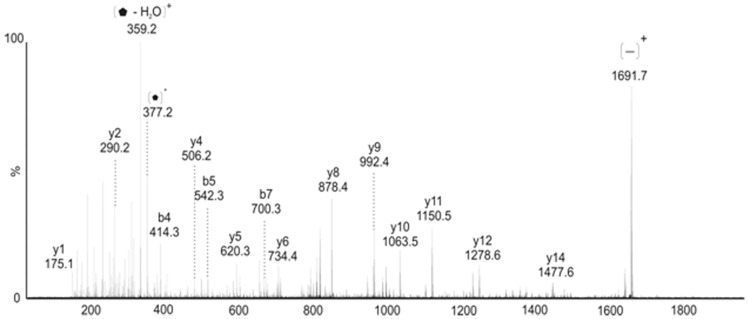
nLC-MS/MS AH-2767 gne mutant polar flagellin glycopeptide spectrum.nLC-MS/MS spectrum of the doubly charged ion at m/z 1034.4 eluting between 13.1 and 13.8 minutes. The peptide sequence was identified by y and b ion series as 94TLAQQSANGSNNTDDR109 which corresponds to both the FlaA and FlaB sequences. The unmodified singly charged peptide ion can be seen at m/z 1691.7, giving a mass excess of 376 Da (pseudaminic acid derivative). The prominent peaks at m/z 377 and 359 correspond to the glycan oxonium ion and its dehydrated form, respectively.